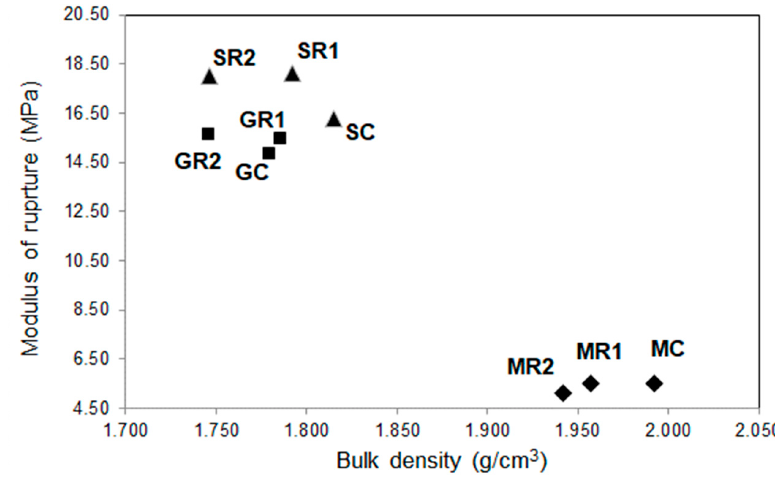
Figure 2. Correlation between bulk density and modulus of rupture of fired products.